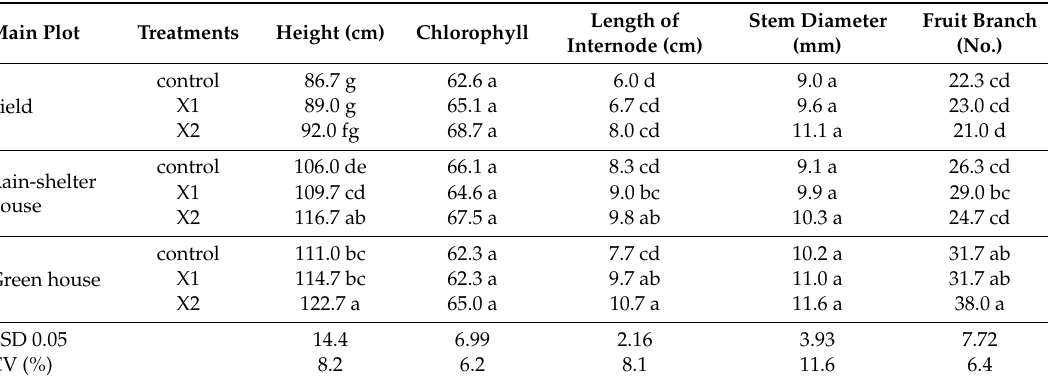
Table 2. Plant growth attributes at 70 DAT.